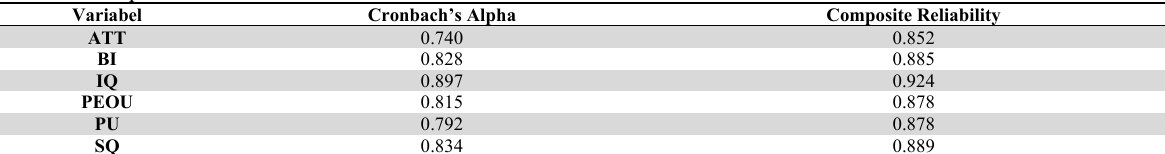
Cronbach’s Alpha and CR Value Variabel Cronbach’s